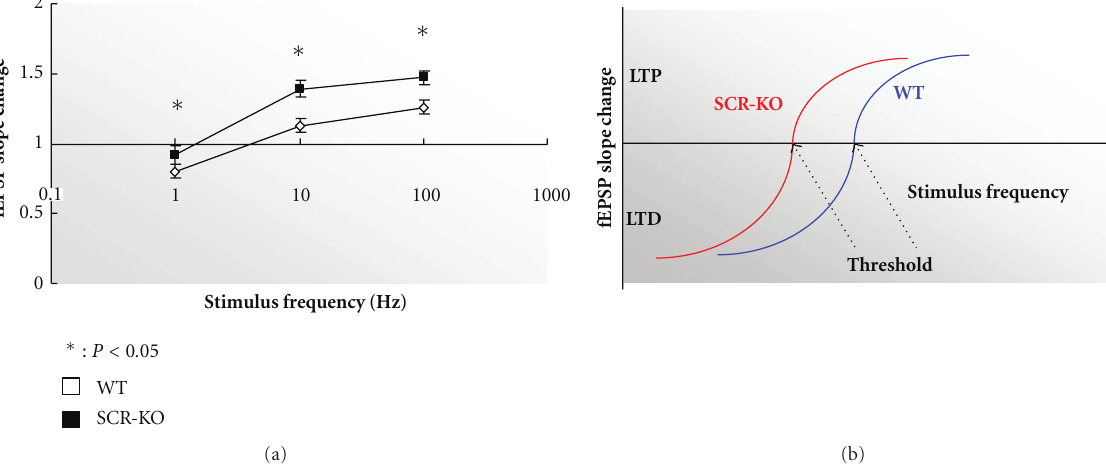
Figure 3: Comparison of the field excitatory postsynaptic potential (fEPSP) slope changes between wild-type (WT) and Scrapper -knockout (SCR-KO) mice at di ff erent stimulation frequencies. (a) Means of 10 consecutive sweeps before and after (45–55 min) stimulation. Mean ( ± SEM) e ff ect of the stimulus of the conditioning stimulation delivered at various frequencies on the response measured 50 min after conditioning ( (cid:4) , WT; (cid:5) , SCR-KO) ∗ P < 0 . 05 ( t -test). (b) Schematic model of the long-term potentiation/depression (LTP/LTD) threshold changes in SCR-KO hippocampus and the dependence on stimulus